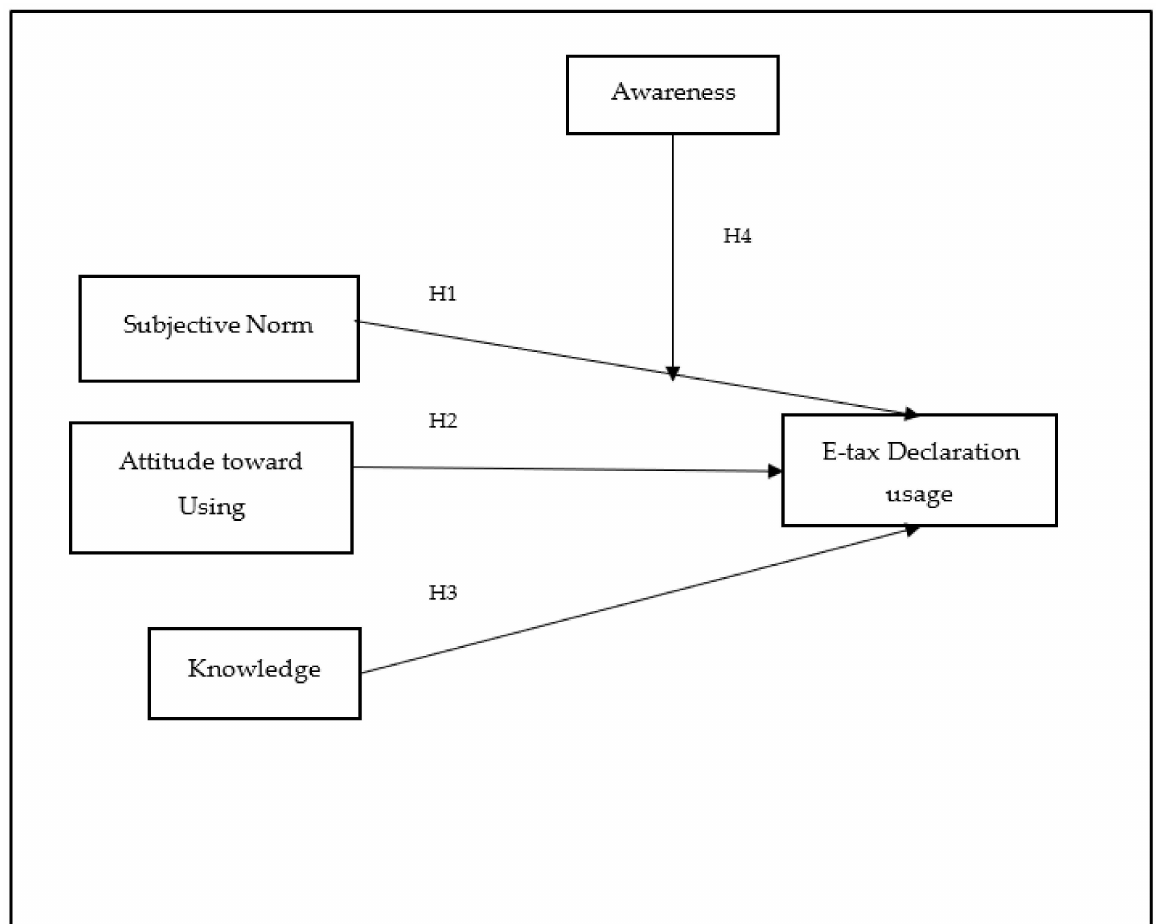
Figure 1. Research